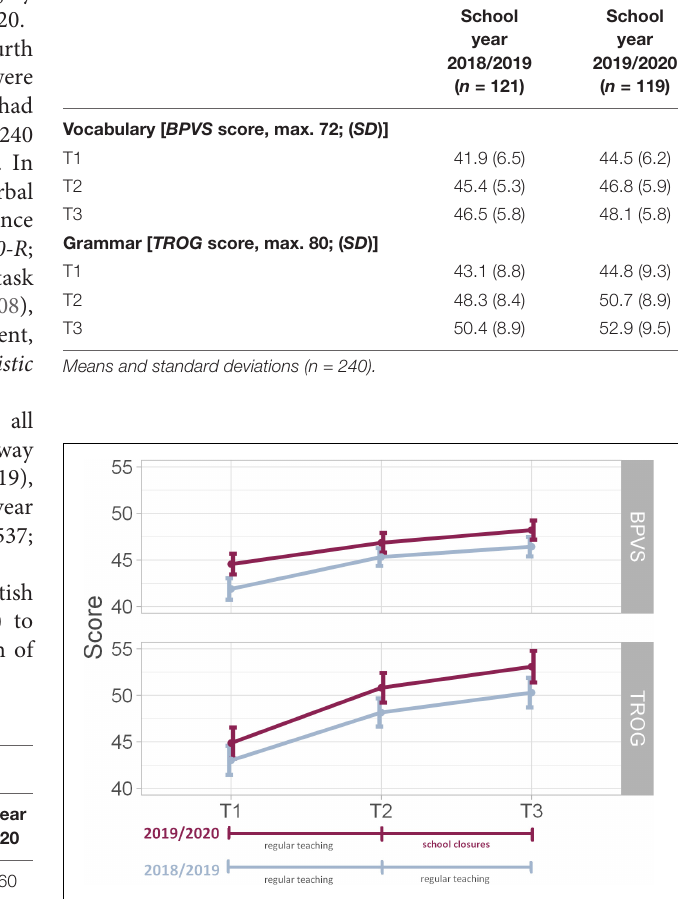
FIGURE 1 | English vocabulary scores (BPVS) and grammar scores (TROG) by Testing Session and Group. Error bars denote 95% confidence intervals ( n =